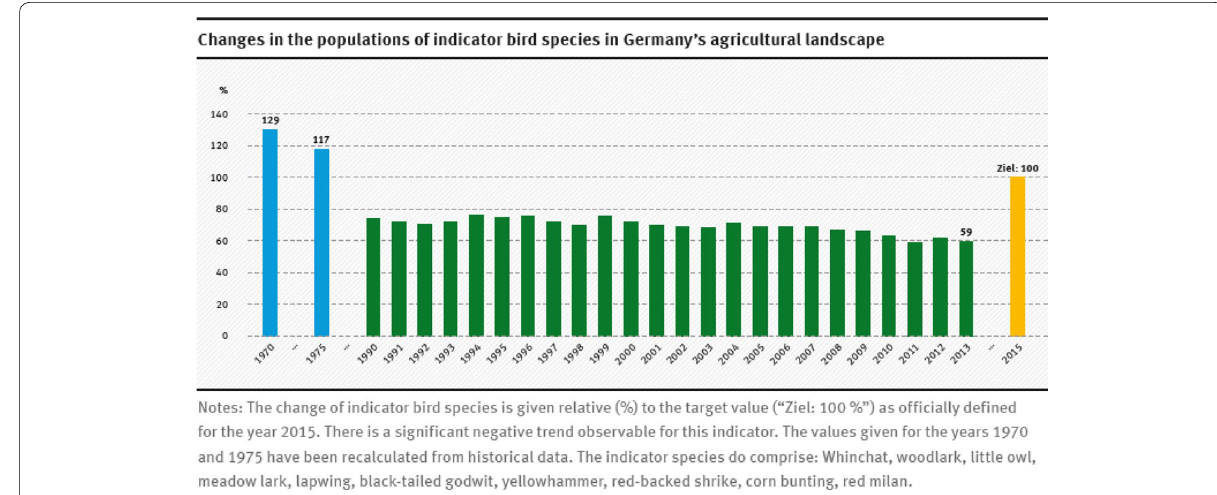
Fig. 3 Changes in the populations of indicator bird species in Germany’s agricultural landscape (Figure copied from